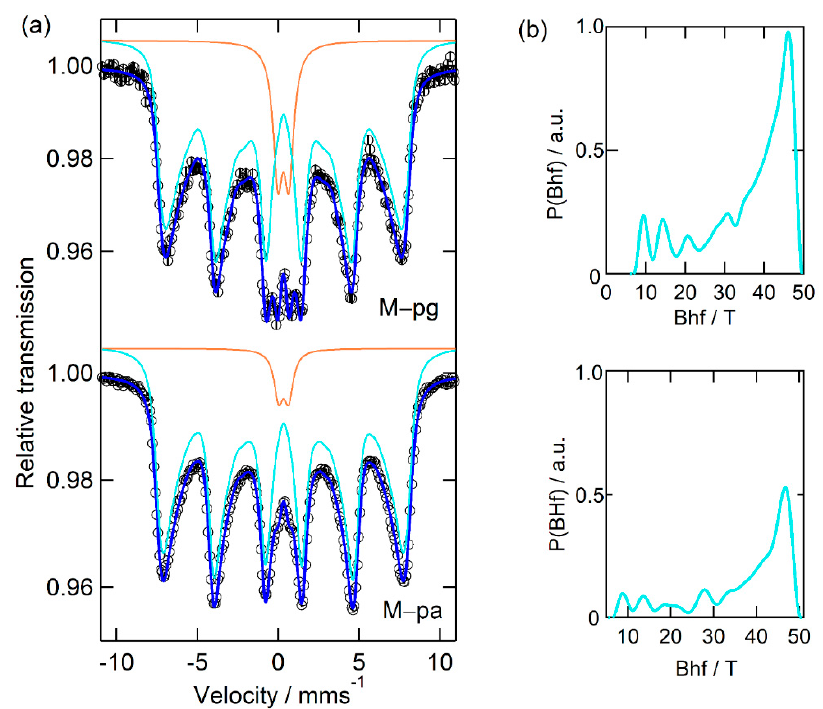
Figure 5. ( a ) Mossbauer experimental spectra (open circles) and fitted curves (blue lines) for samples synthetized with the assistance of mixed media at 2:1 ratio: pectin–gelatin (M–pg) and pectin–agar- agar (M–pa). The cyan lines correspond to the contribution of magnetic hyperfine interactions and are associated to the magnetic hyperfine field distributions shown in ( b ). The orange lines represent the components fitted with quadrupole doublets and are related to a superparamagnetic behavior of the smaller NP. Table 5. Mössbauer hyperfine fitting parameters for NP M–g, M–p and M–a. <B hf >( σ ): average magnetic hyperfine field and standard deviation of the magnetic field distribution; IS: isomer shift; ε : quadrupole shift; Γ : Lorentzian line width; I: relative area. Uncertainties in I are less than 2%.